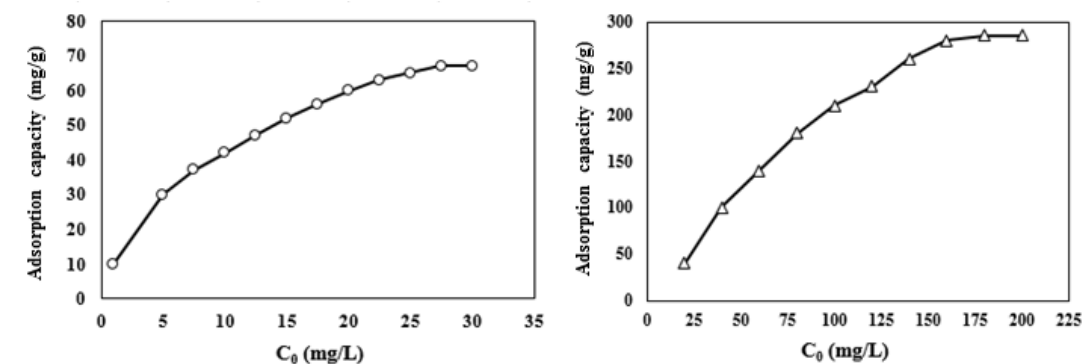
Fig. 6. Effect of initial concentration of Hg 2+ (left) and Pb 2+ (right) adsorption onto NiO/ZSM-5 (pH=8, T=298 K, contact time for Pb (II)=220 min and for Hg (II)=180 min ).